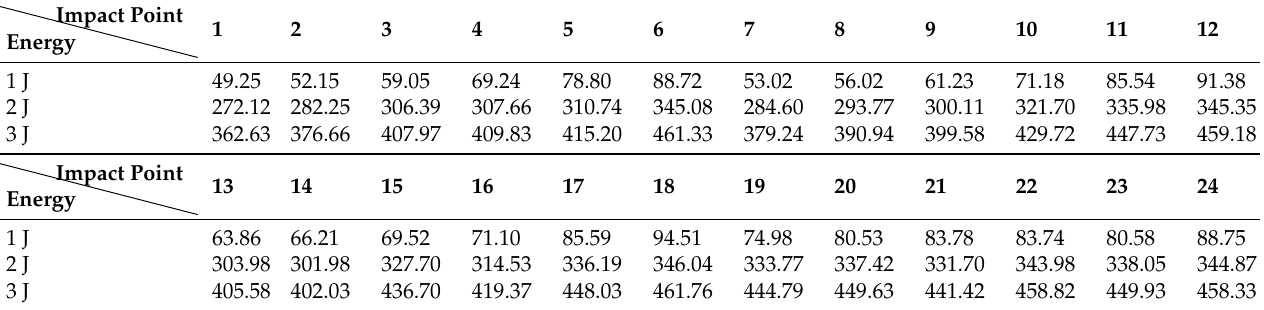
Table 6. Impact energy eigenvalues at 1–3